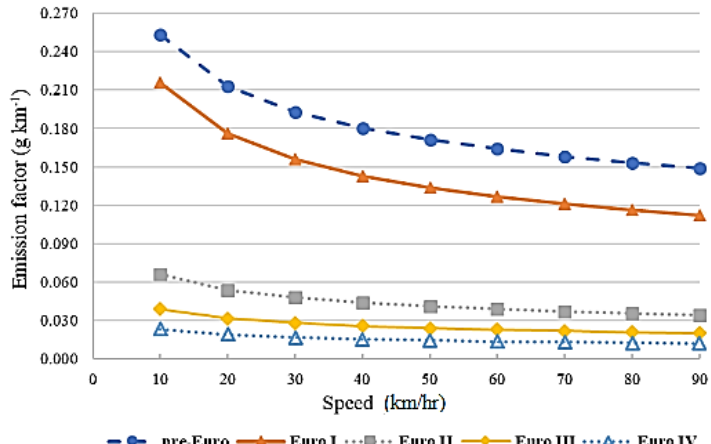
Figure 1. PM emission factors vs. vehicle speeds for (diesel) vans.